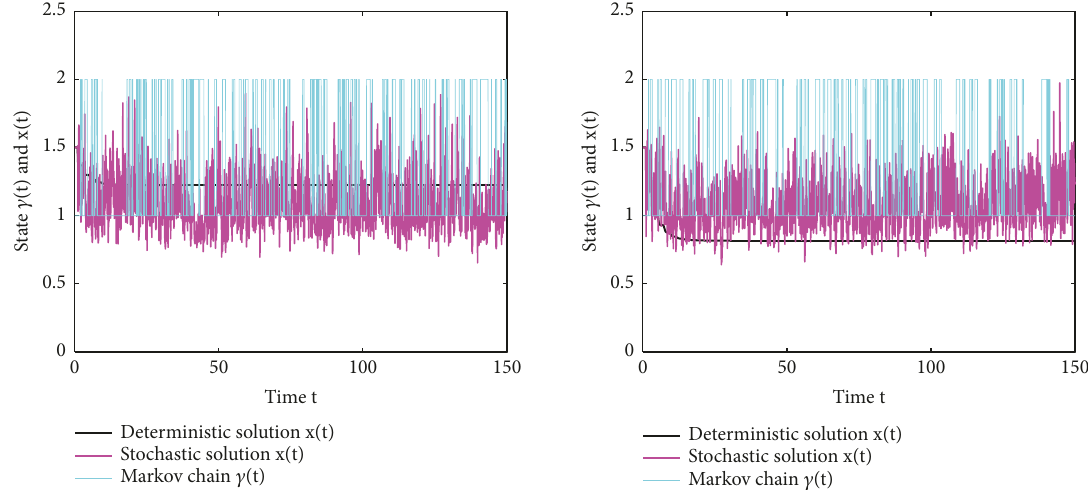
Figure 1: Stochastic and deterministic trajectories of model (6).